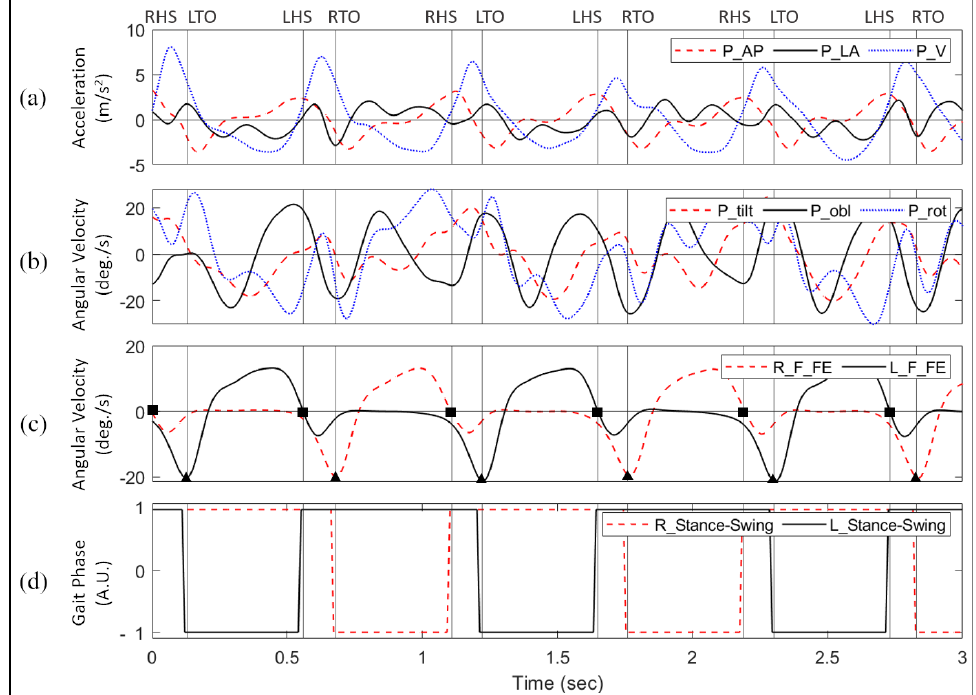
Figure 2. Input signals consist of ( a ) acceleration signals; ( b ) angular-velocity signals from the pelvis. ( c ) Groundtruth is extracted by identifying events from the angular-velocity signals from the feet. ( d ) The stance and swing phase signals were generated for the right and left foot as two continuous groundtruth signals for the regression-based